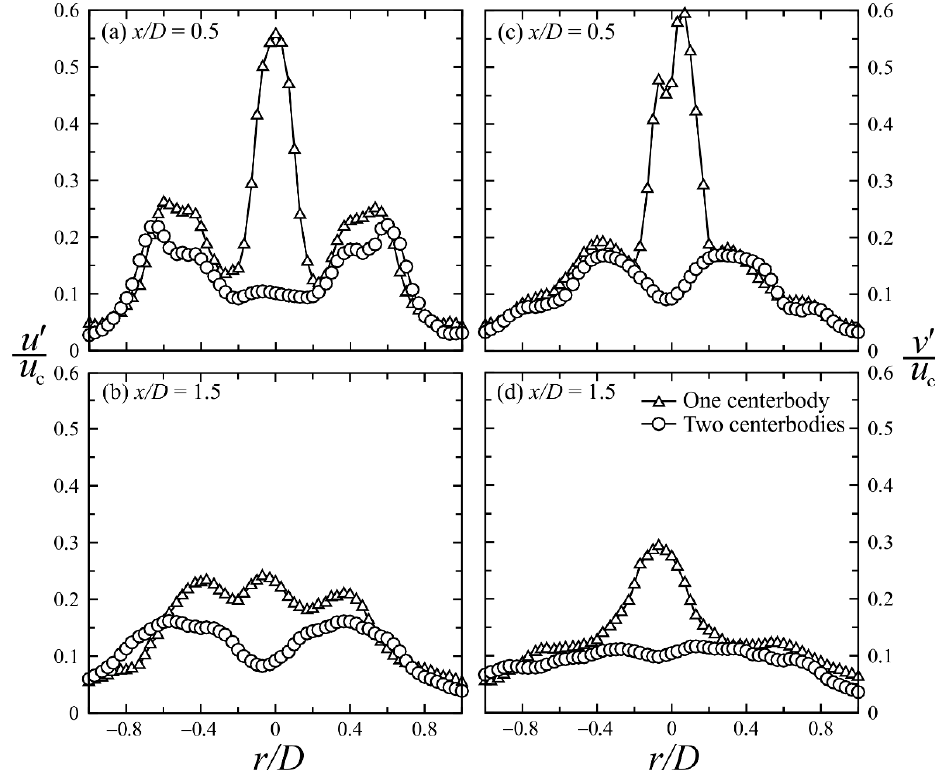
Figure 9. Radial distributions of normalized fluctuation intensities at x/D = 0.5 and 1.5. Re c = 280, Re a = 480, and S = 0.432. ( a , b ) Axial component, ( c , d ) radial component. Figure 9c,d present the normalized radial fluctuation intensities (𝑣 (cid:4593) /𝑢 (cid:3030) ) distributed in the radial direction at x/D = 0.5 and 1.5, respectively. Similar to what occurred in Figure 9a,b for both the one- and two-centerbody cases, the radial fluctuation intensities (𝑣 (cid:4593) /𝑢 (cid:3030) ) decrease with increasing axial distance. The profile of (𝑣 (cid:4593) /𝑢 (cid:3030) ) in the turbulent forward- flow wake displays a curve similar to that in the case of one centerbody at |𝑟/𝐷| > 0.2 and x/D < 1.5. Consequently, the axial momentum of the central jet fluids is transferred to the radial direction when CD2 is installed. In other words, this transformation of momentum induces a relative rise in the axial and radial fluctuation intensities in the jets’ wake region.